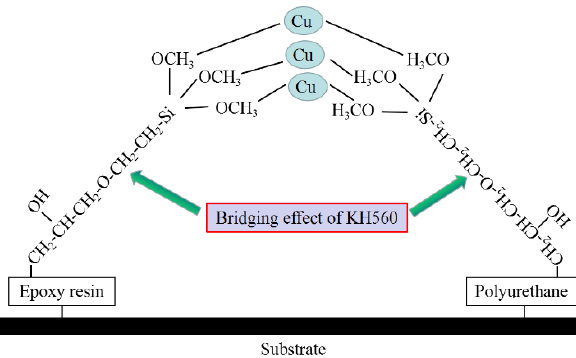
Figure 5. Schematic for the bridging effect of